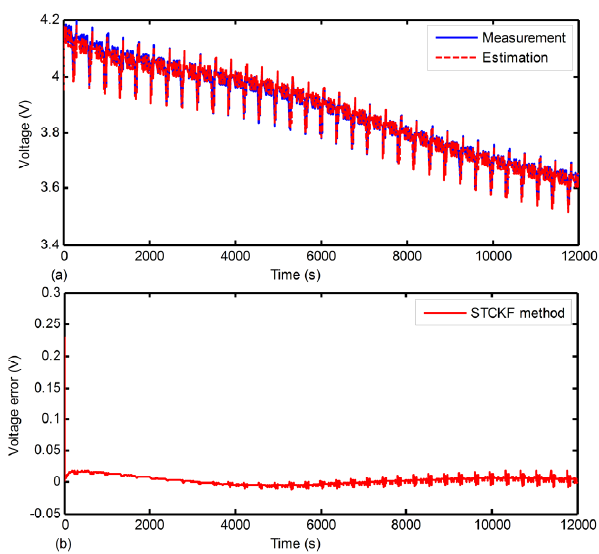
Figure 7. Terminal voltage estimation under DST: ( a ) Voltage profile; and ( b ) Voltage estimation error profile.